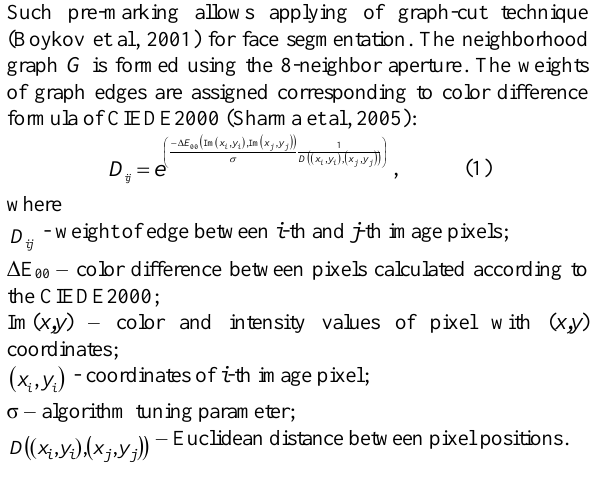
Figure 2. Automatic face pre-marking based on facial feature point